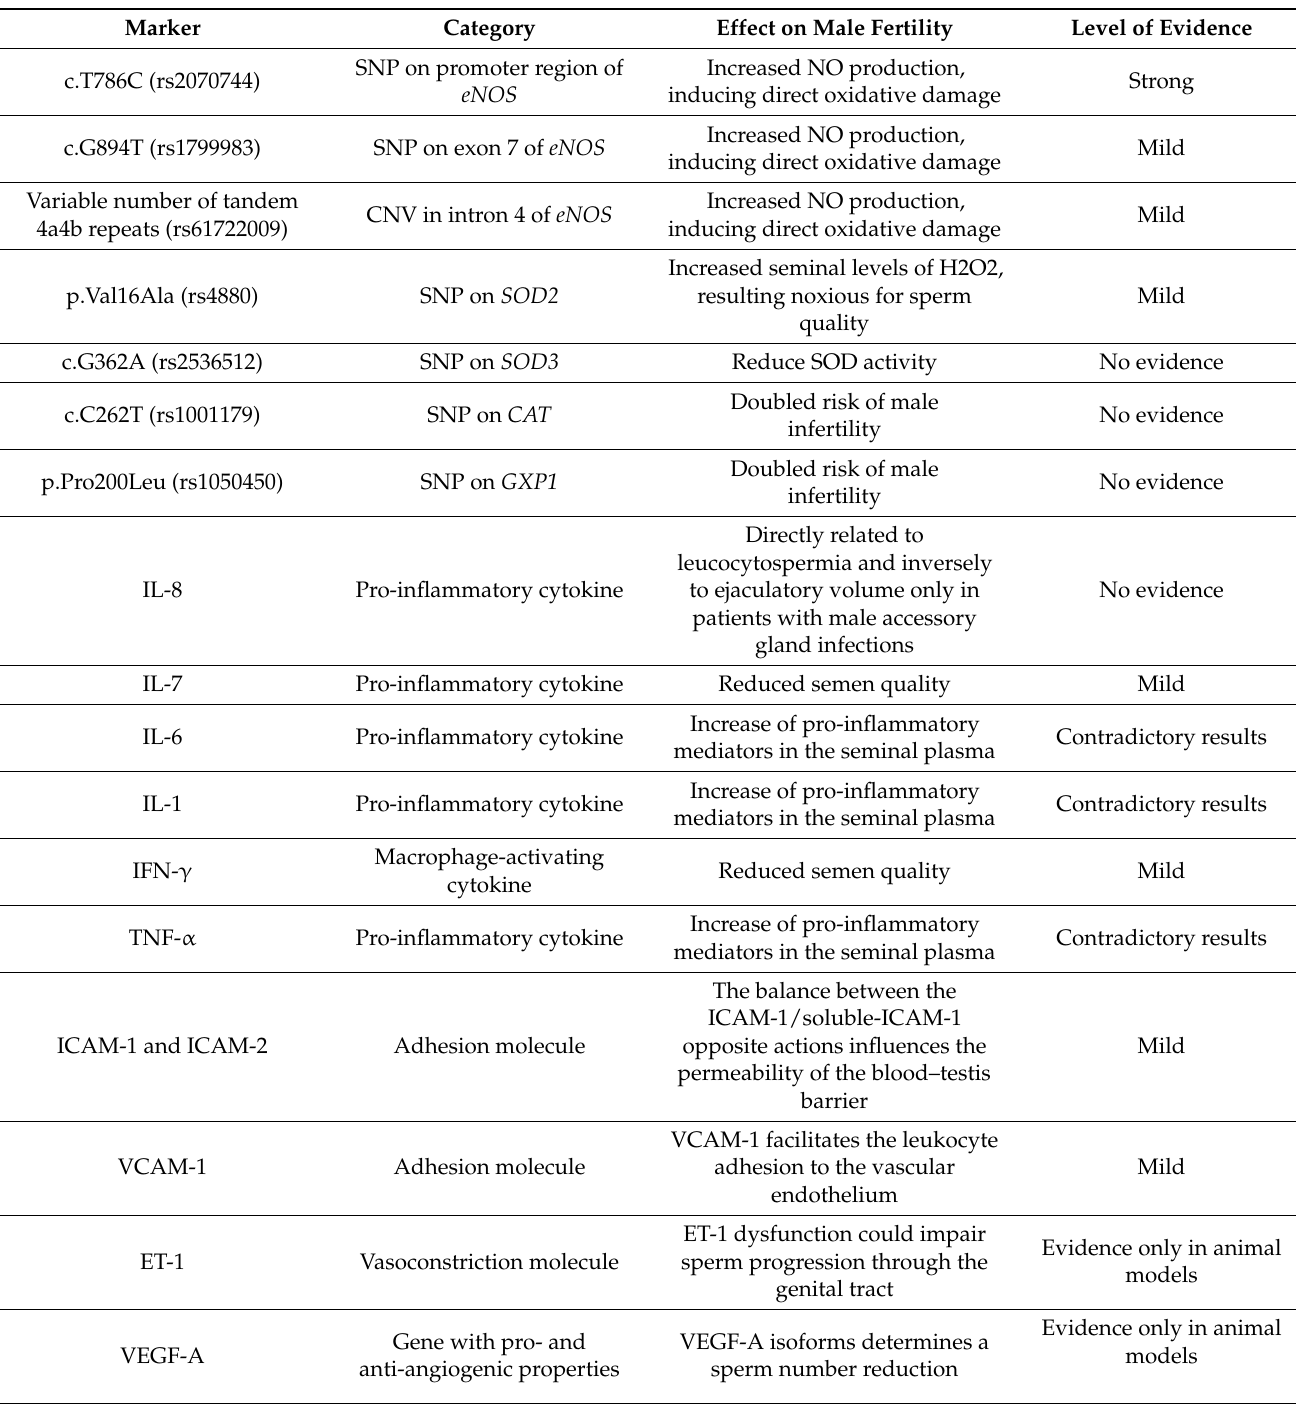
Table 3. Potential markers of male infertility. The level of evidence is determined through studies available in the literature.